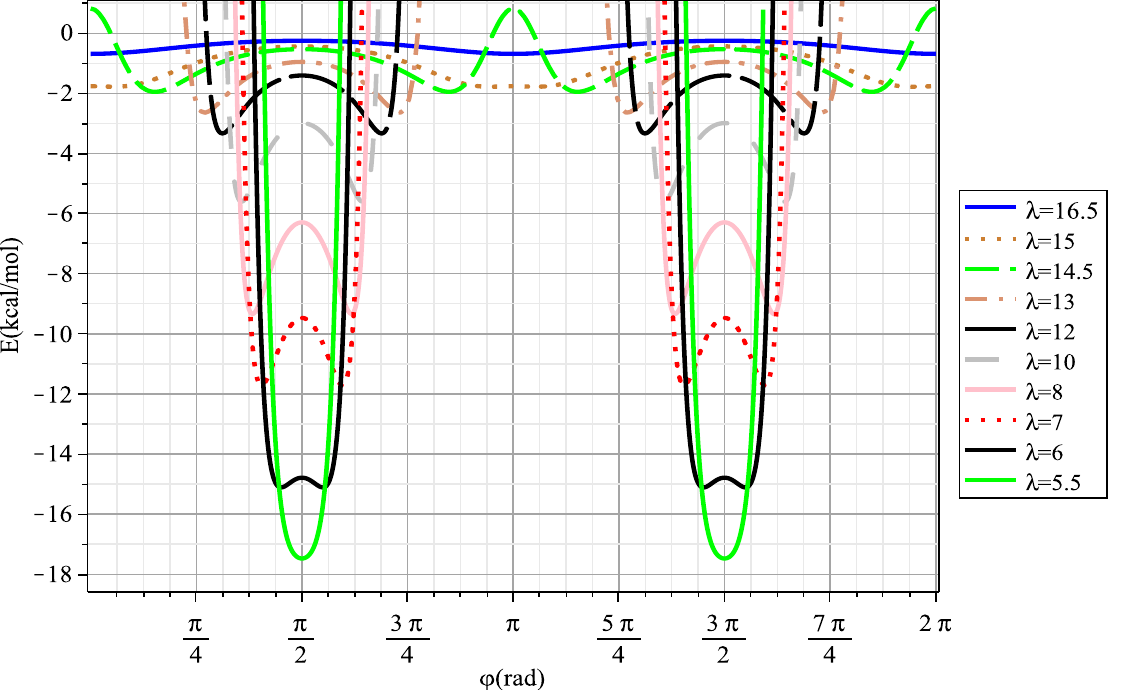
Figure 4. Total energies of Cis molecules binding to DNA with respect to ϕ for ψ = π